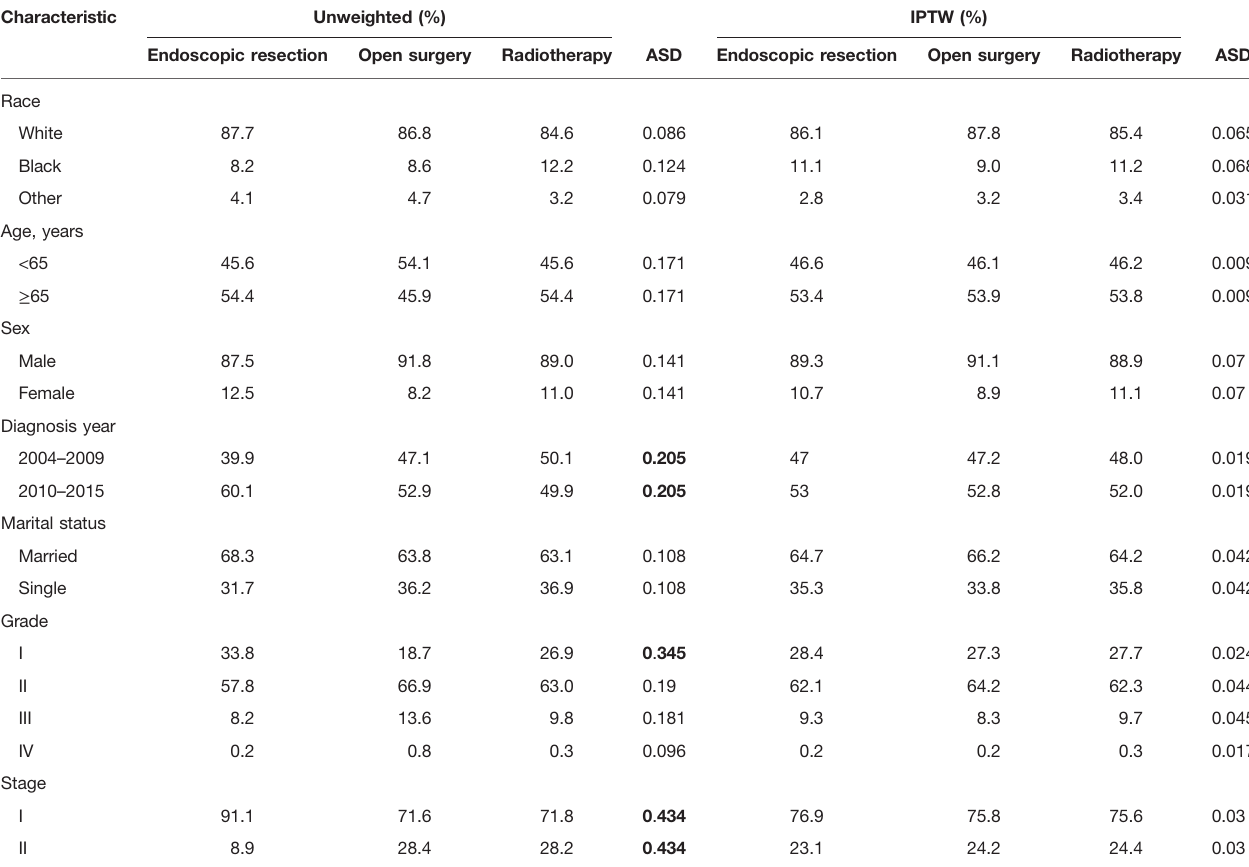
TABLE 1 | Baseline characteristics in the three treatment groups before and after propensity score weighting.